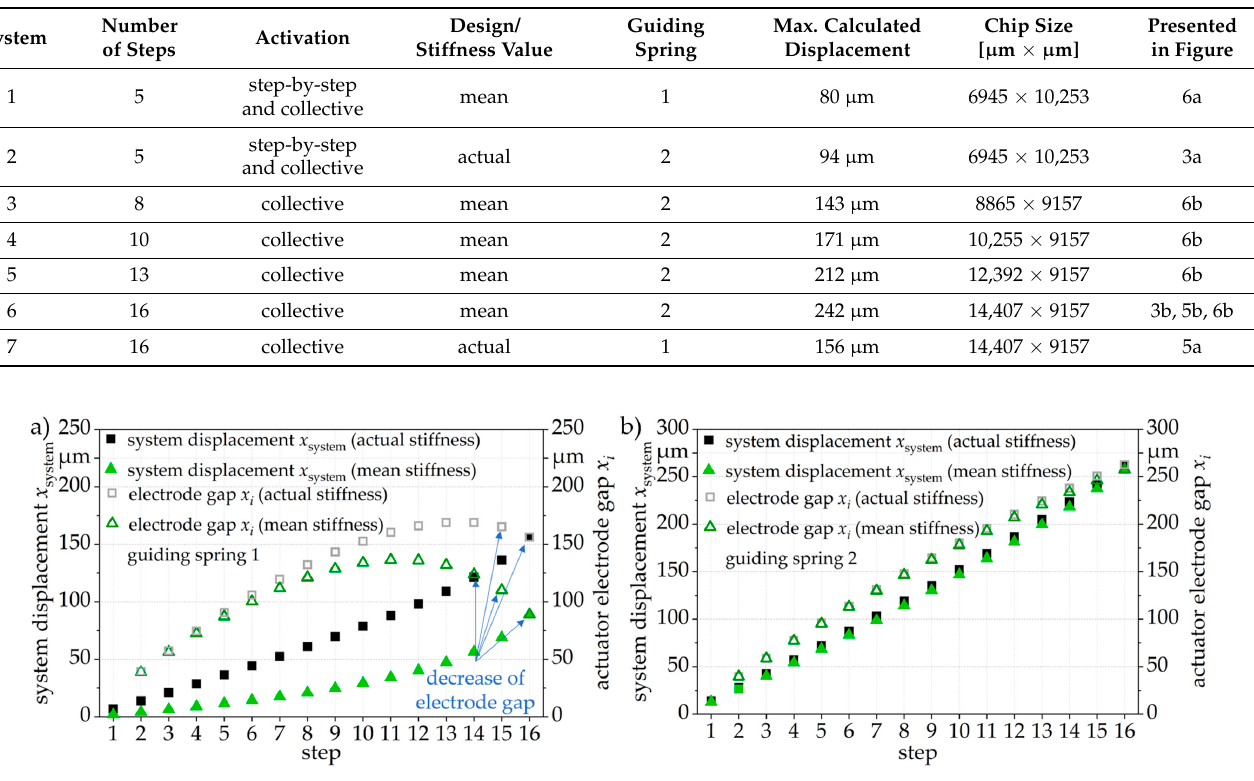
Figure 4. ( a ) Geometry of the guiding springs 1 and 2; ( b ) stiffness of guiding springs 1 and 2 based on solid state COMSOL Multiphysics simulation.